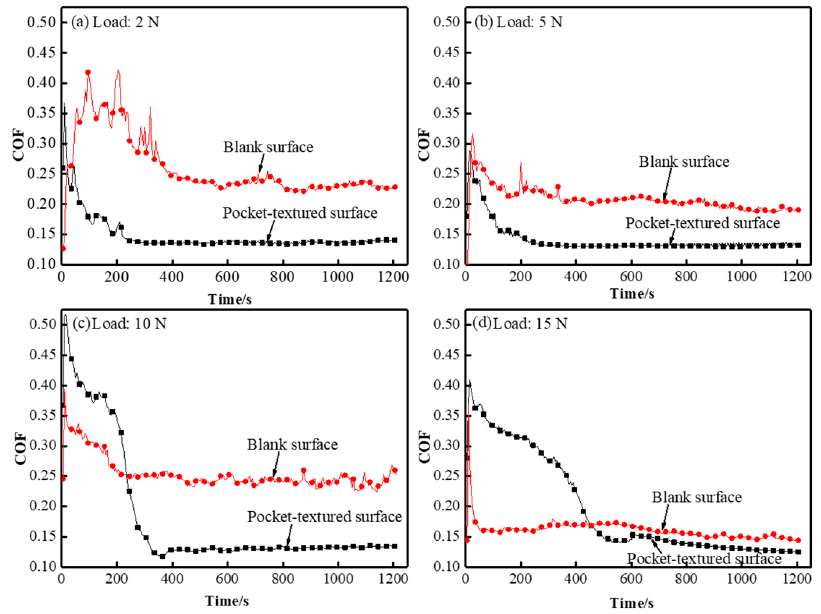
Figure 8. COF comparison of the pocket-textured surface and the blank surface under different loads of ( a ) 2 N, ( b ) 5 N, ( c ) 10 N and ( d ) 15 N with a constant sliding frequency of 0.5